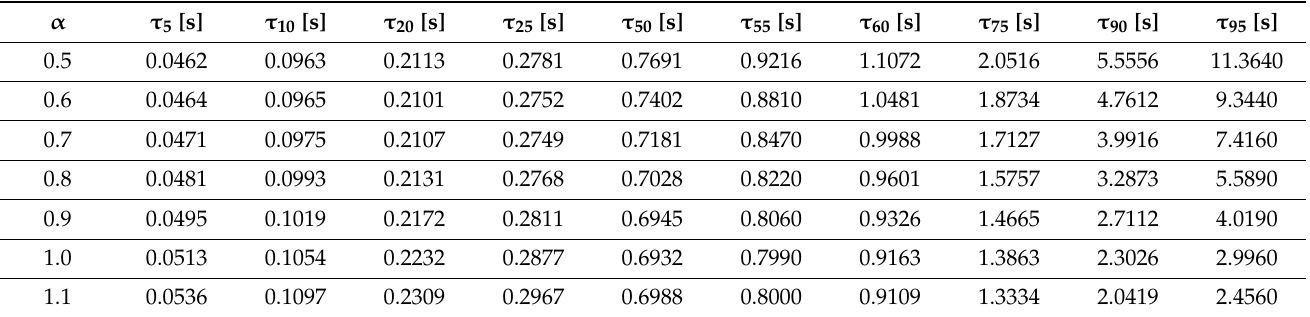
Table 1. Numeric values of normalized times τ 5 , τ 10 , τ 20 , τ 25 , τ 50 , τ 55 , τ 60 , τ 75 , τ 90 , and τ 95 , respec- tively, for different values of α , with 0.5 ≤ α ≤ 1.1.